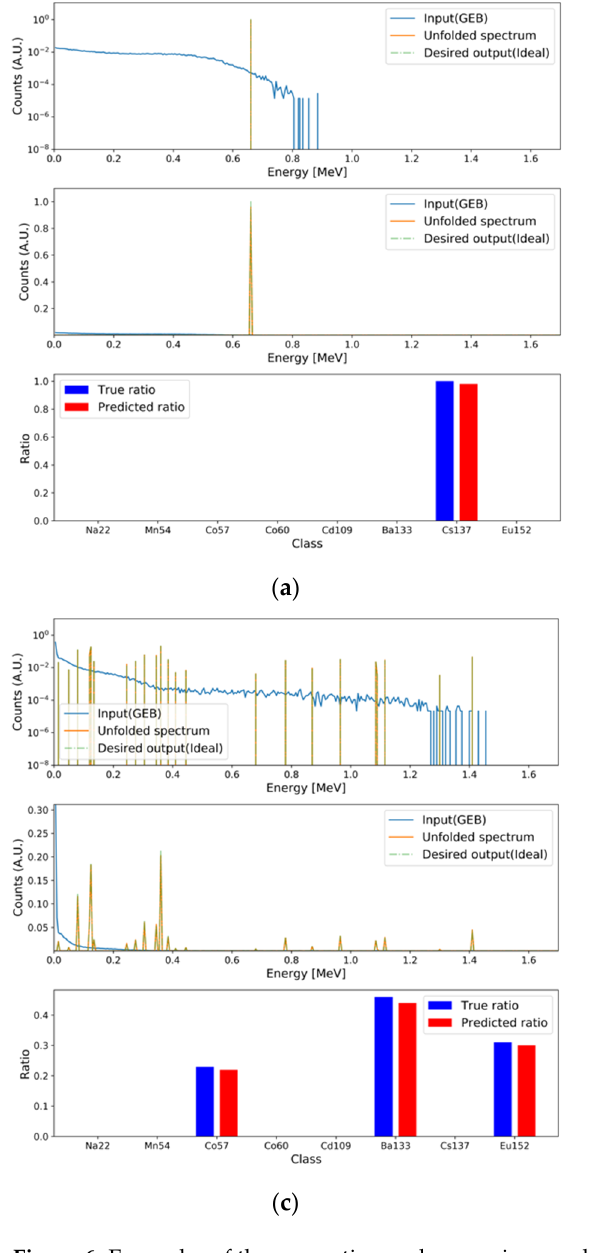
Figure 6. Examples of the generation and regression results for the test set. In each subfigure, the top and middle figures are plotted with log and linear scales for the y -axis because of the difference in scales for the FEP and GEB spectra. The mean averaged percentage errors (MAPEs) for the generation and regression tasks, respectively, were ( a ) 9.083 × 10 − 2 and 5.208 × 10 − 1 ; ( b ) 2.963 × 10 − 2 and 0.557; ( c ) 3.974 × 10 − 1 and 3.735; ( d ) 2.331 × 10 − 1 and